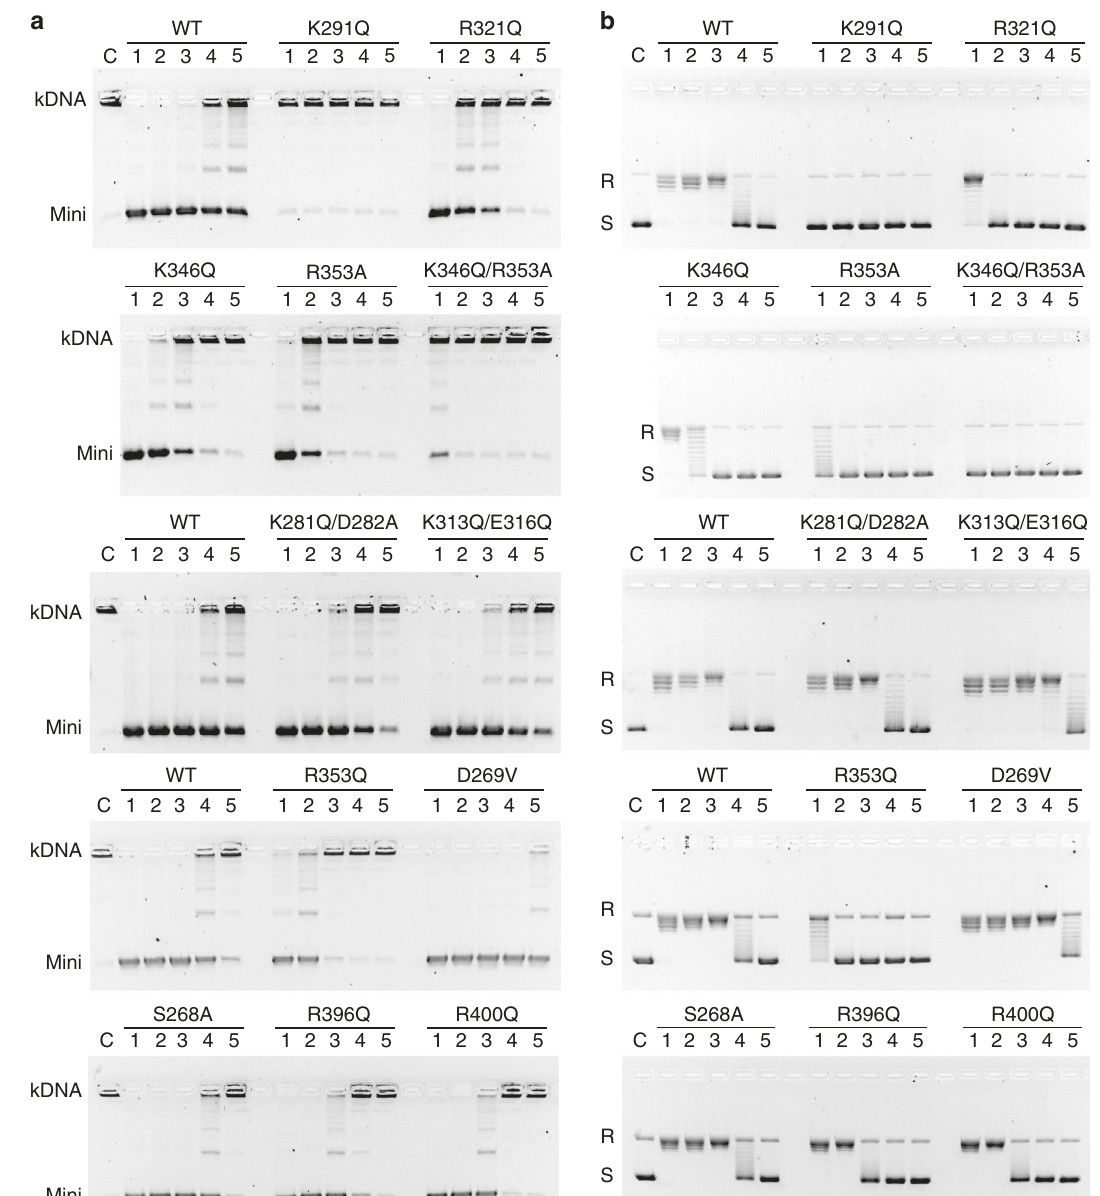
Fig. 5 Mutations of ParE cavity residues affect DNA strand passage by topo IV. Complexes of topo IV reconstituted with ParE bearing cavity mutations at residues K291, R321, K346 or R353 exhibit greatly reduced DNA decatenation ( a ) and DNA relaxation ( b ) activities. a A representative decatenation experiment. For each panel, kinetoplast DNA was incubated at 37 °C for 1 h in decatenation buffer (40 mM Tris-HCl (pH 7.5), 6 mM MgCl 2 , 10 mM DTT, 200 mM potassium glutamate, 50 µ g ml − 1 BSA) with 1 mM ATP and S. pneumoniae topoisomerase IV reconstituted from a fi xed amount of ParC (25 ng) (and in experiments not shown up to 2000 ng) and titrated with either wild-type or mutant ParE (as indicated) at 100, 20, 10, 5 and 2.5 ng (lanes 1 – 5, respectively in each panel). Reactions were terminated and the DNA products were separated and visualized by electrophoresis in 1% agarose gels. Lane C, no enzyme addition. kDNA, kinetoplast DNA; Mini denotes minicircle DNA released by topo IV. Intermediate bands are partially unlinked DNA species. b Relaxation assays for topo IV were carried as described for kDNA decatenation except supercoiled plasmid pBR322 DNA (400 ng) was used as substrate with the same level of ParC (25 ng) and wild-type or mutant ParE at 100, 40, 20, 10 and 5 ng (each panel lanes 1 – 5, respectively). DNA products were analysed on 1% agarose gels. Lane C, no enzyme addition. R and S, relaxed and supercoiled DNA,